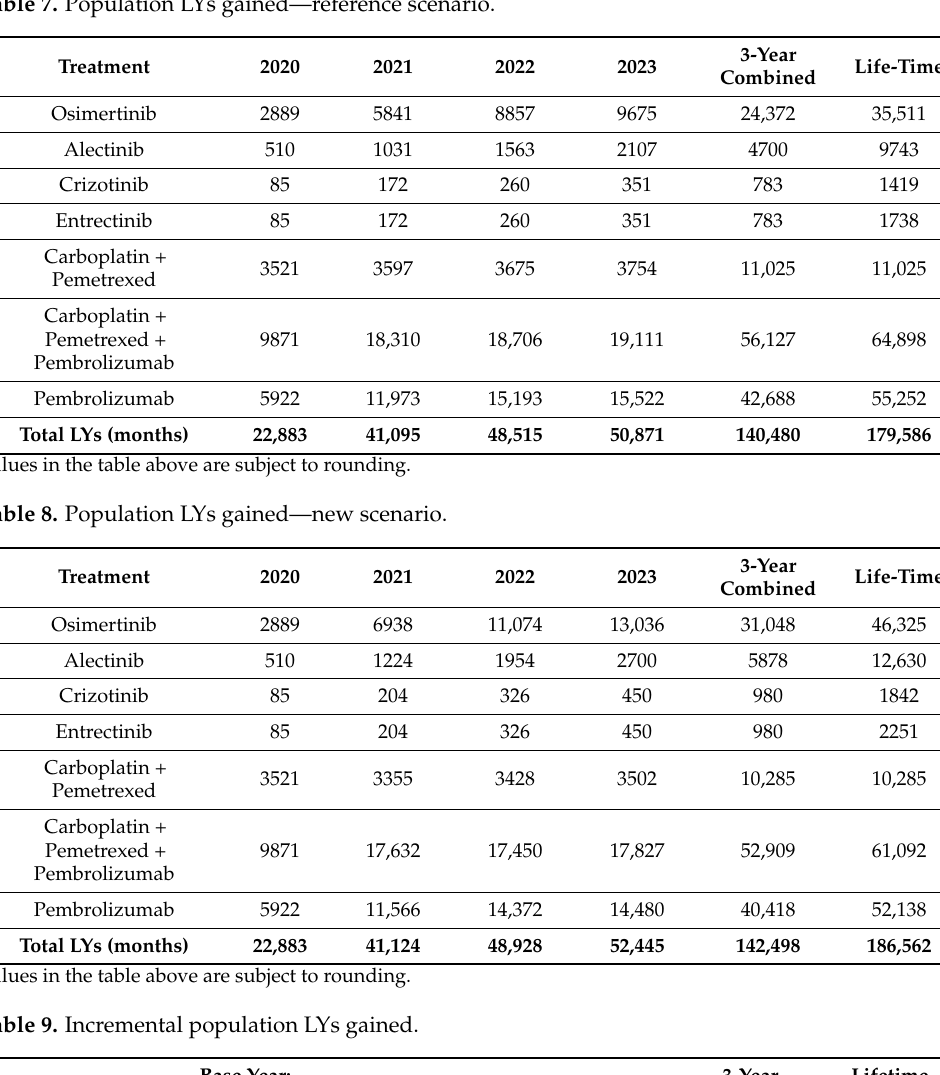
Table 7. Population LYs gained—reference scenario.